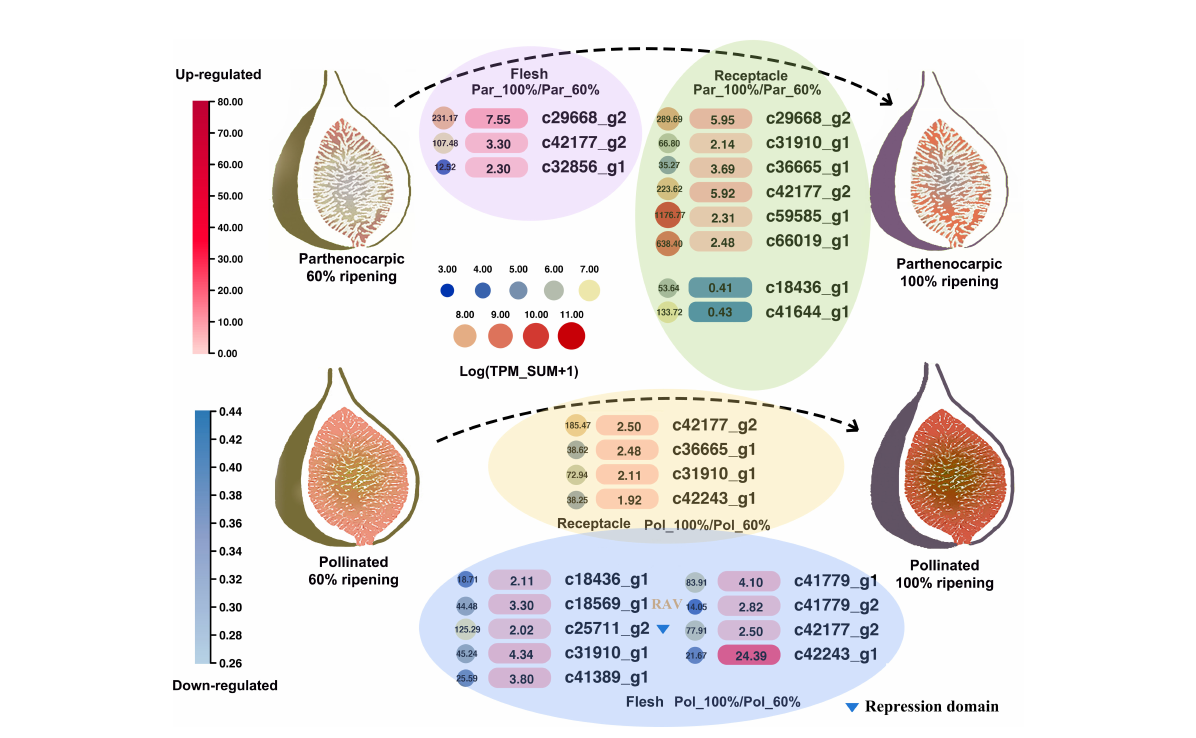
FIGURE 8 Changes in FcAP2/ERF gene expression between fi g fruit fl esh and receptacles at 60% and 100% ripeness in pollinated and parthenocarpic fruits. Color intensity indicates the ratio of expression in 100% compared to 60% ripe